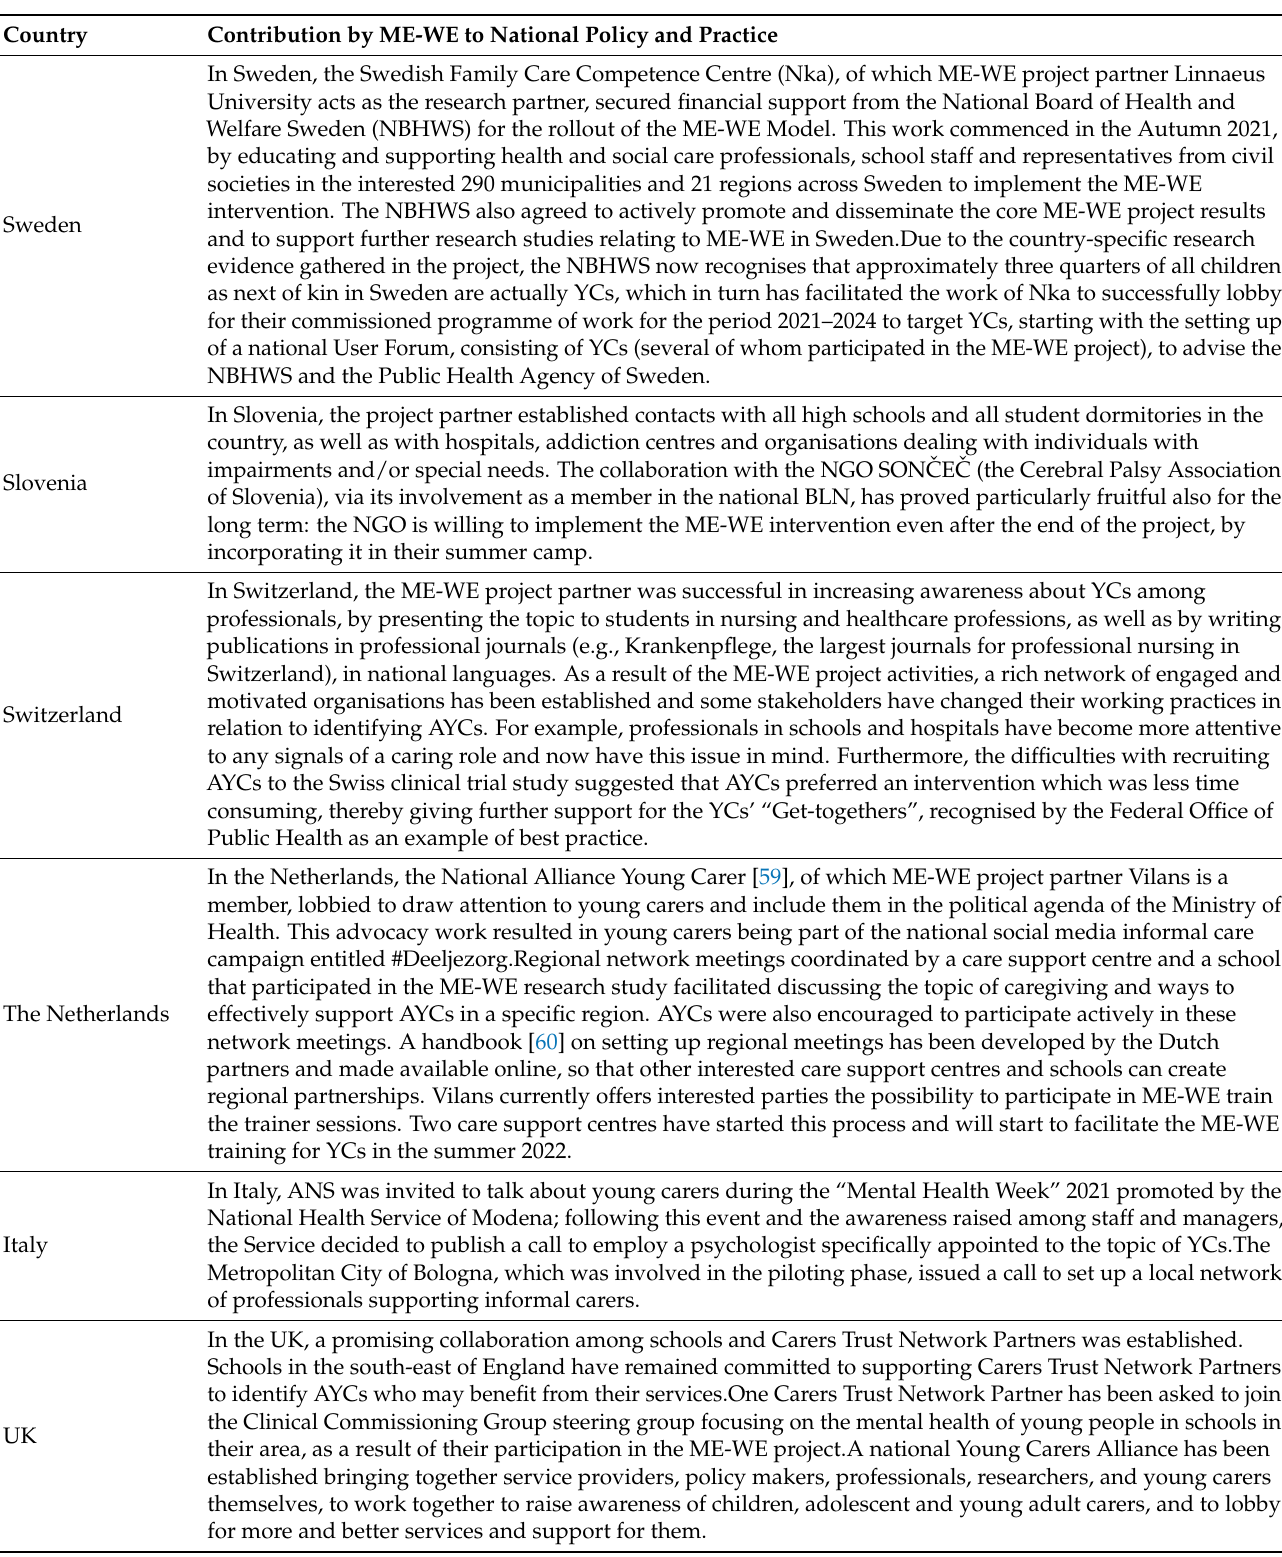
Table 12. Advocacy and lobbying actions by ME-WE to influence national policy and